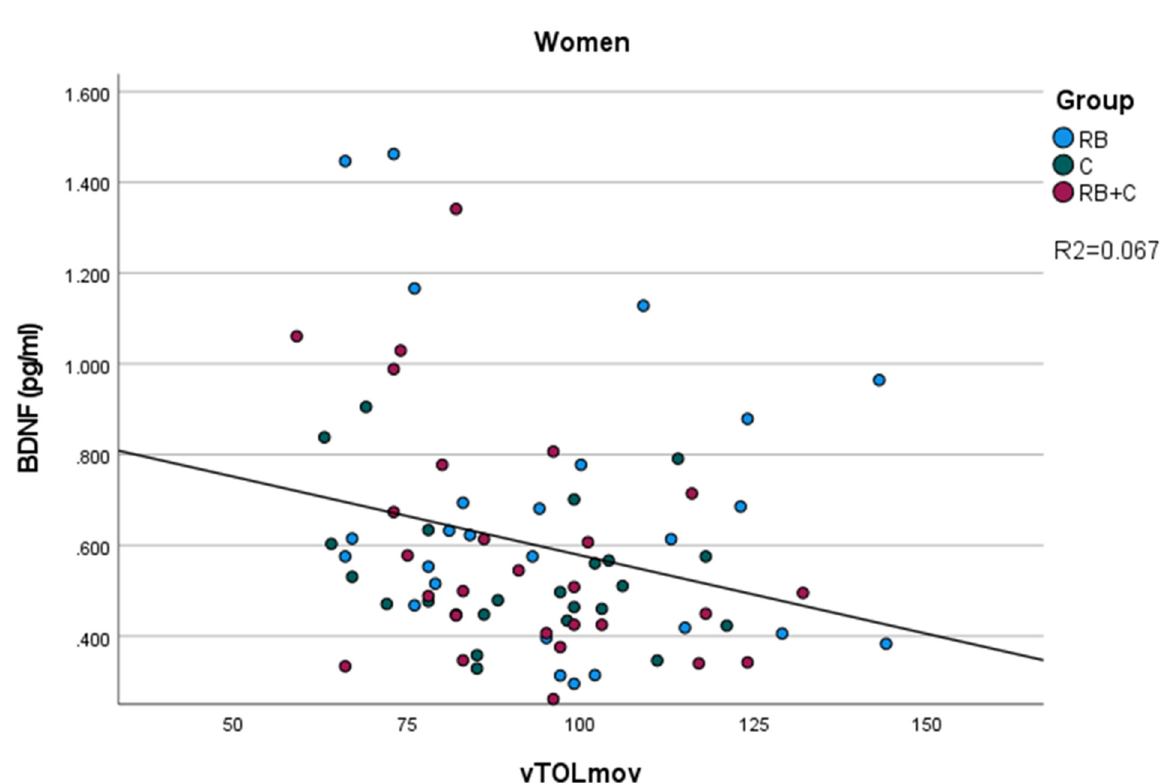
Figure 1. Correlations between levels of BDNF in blood and number of movements required to finish the tower of London (vTOLmov) in women.